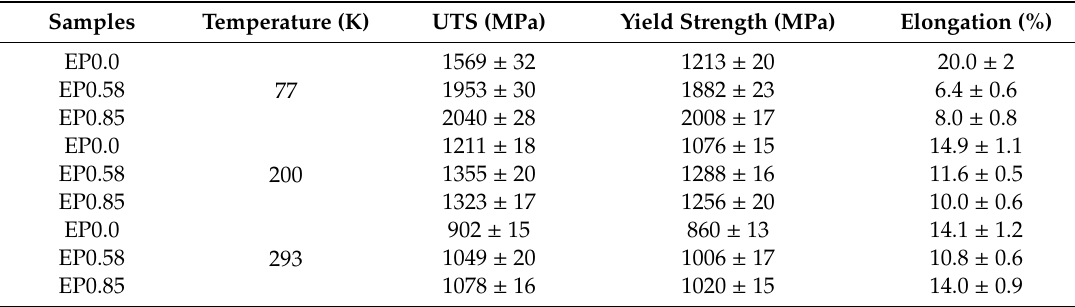
Table 1. The values of ultimate tensile strength, yield strength, and elongation of the TNTZO alloys with di ff erent cold deformations